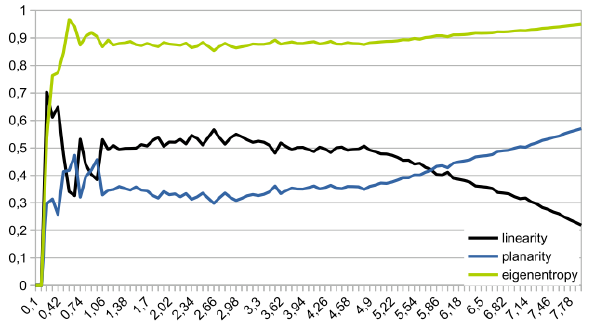
Figure 5. Linearity, Planarity and Eigenentropy as functions of radius in meter. Horizontal axis shows the radius of the neighbourhood in meters. Vertical axis shows the value of the metrics.